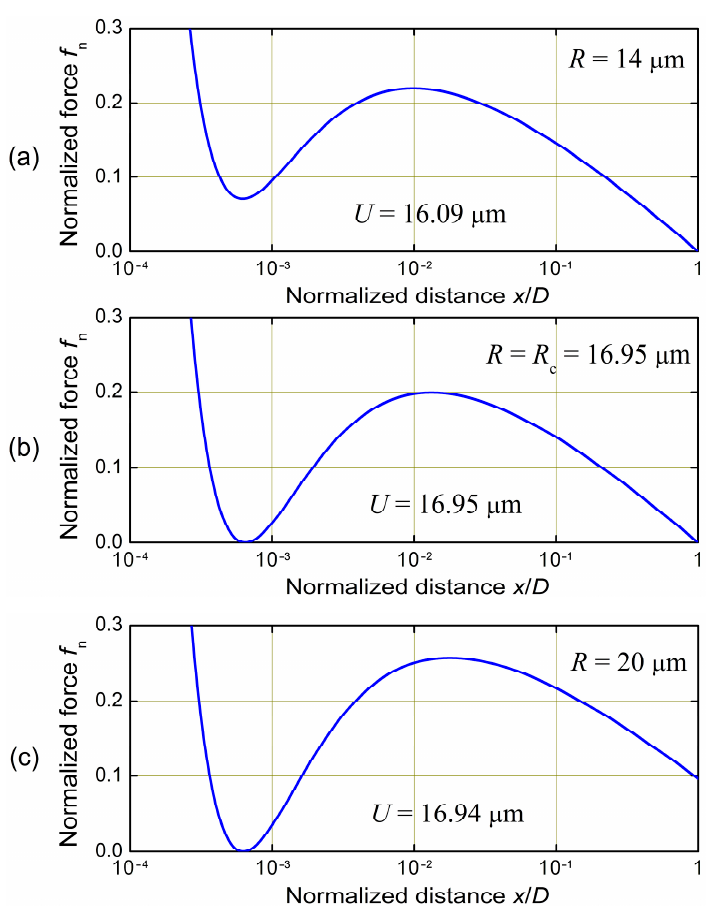
Figure 8. Characteristic x -dependences of the normalized force f n in the approximation (10) are shown on a logarithmic scale along the abscissa; see details in the text.